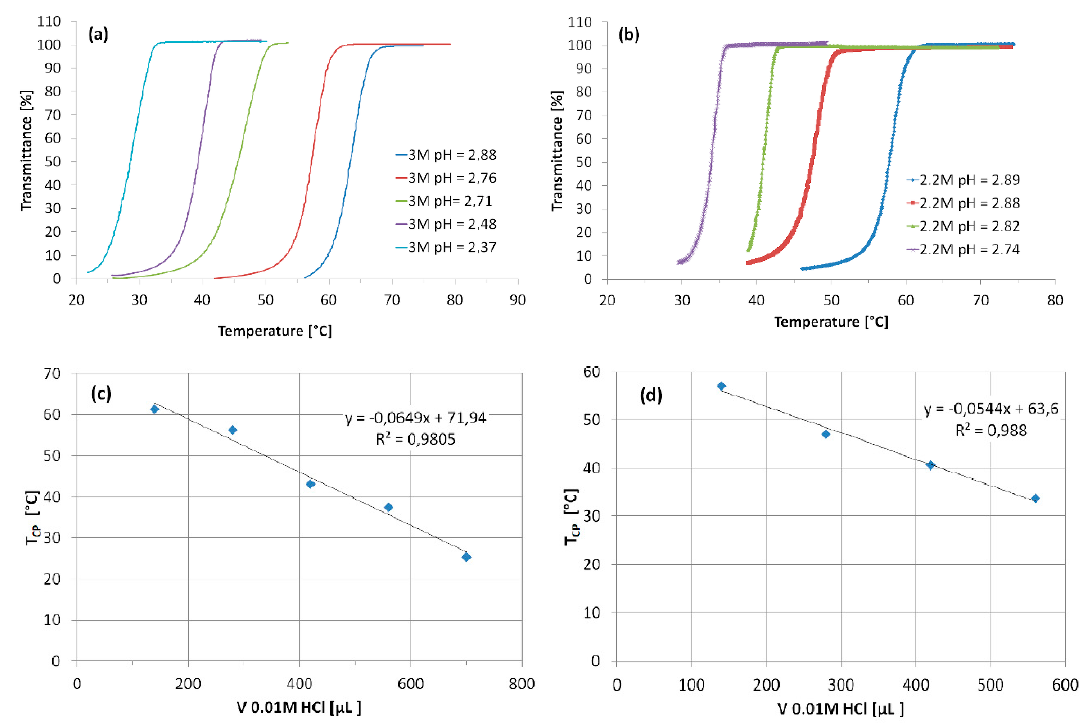
Figure 2. T CP curves for 0.25% L1 in a 3 M KCl solution ( a ) and 2.2 M KCl ( b ); the linear decrease of T CP of 0.25% L1 as the volume of 0.01 M HCl increased in 3.0 M KCl ( c ) and 2.2 M KCl solutions ( d ).